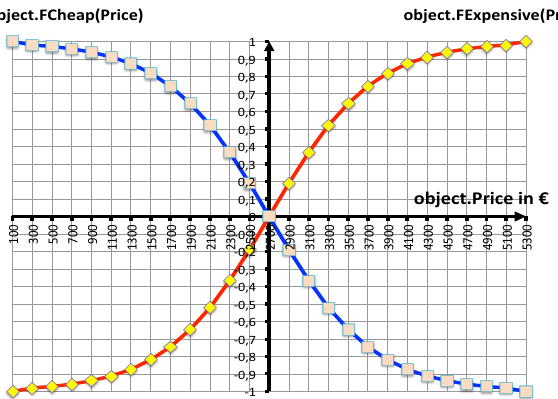
Figure 7. Price Membership functions FCheap() and FExpensive()